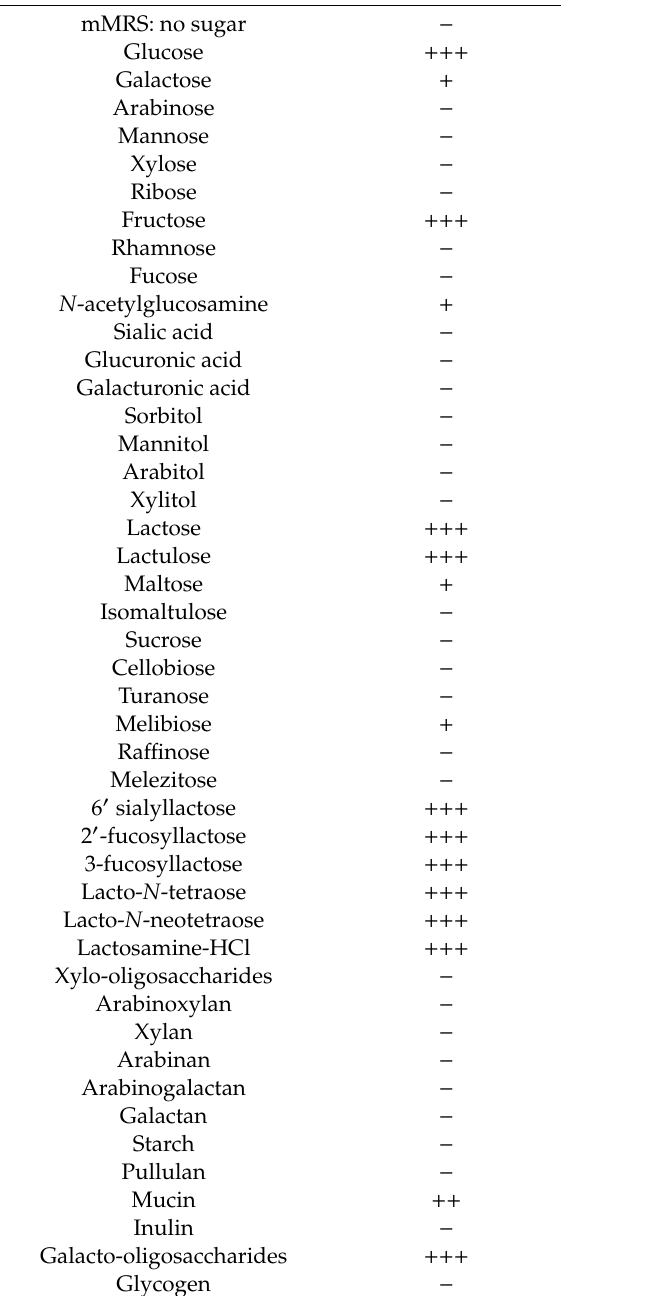
Table 3. Carbohydrate utilisation profile of B. bifidum CNCM